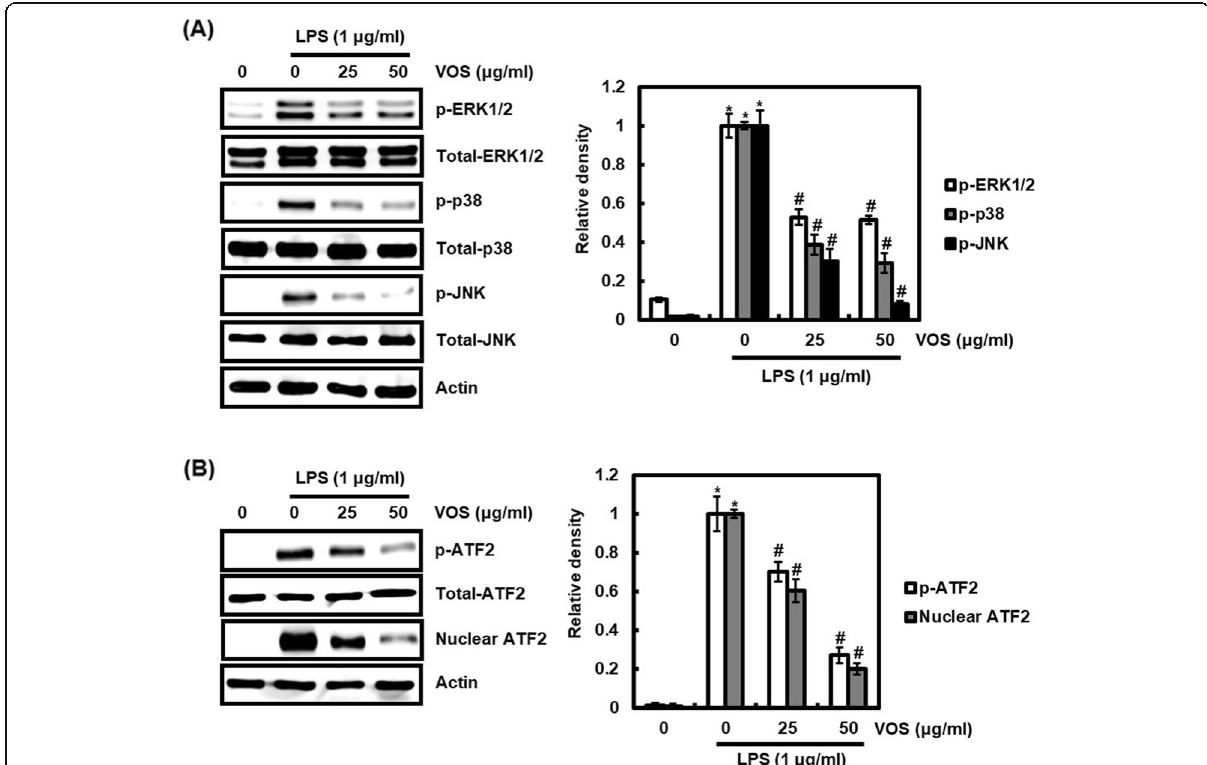
Fig. 7 Effect of VOS on MAPK/ATF2 signaling activation. a RAW264.7 cells were pretreated with VOS for 6 h and then co-treated with LPS (1 μ g/ ml) for 20 min. b RAW264.7 cells were pretreated with VOS for 6 h and then co-treated with LPS (1 μ g/ml) for 30 min. After the treatment, the nucleus fraction was prepared. For Western blot analysis, the cell lysates were subjected to SDS-PAGE and the Western blot was performed using antibodies against p-ERK1/2, p-p38, p-JNK p-ATF2 and ATF2. Total-ERK1/2, total-p38 and total-JNK and actin were used as internal control for Western blot analysis. The density of Western blot bands was calculated using the software UN-SCAN-IT gel version 5.1 (Silk Scientific Inc. Orem, UT, USA). * P < 0.05 compared to the cells without the treatment, and # P < 0.05 compared to the cells treated with LPS